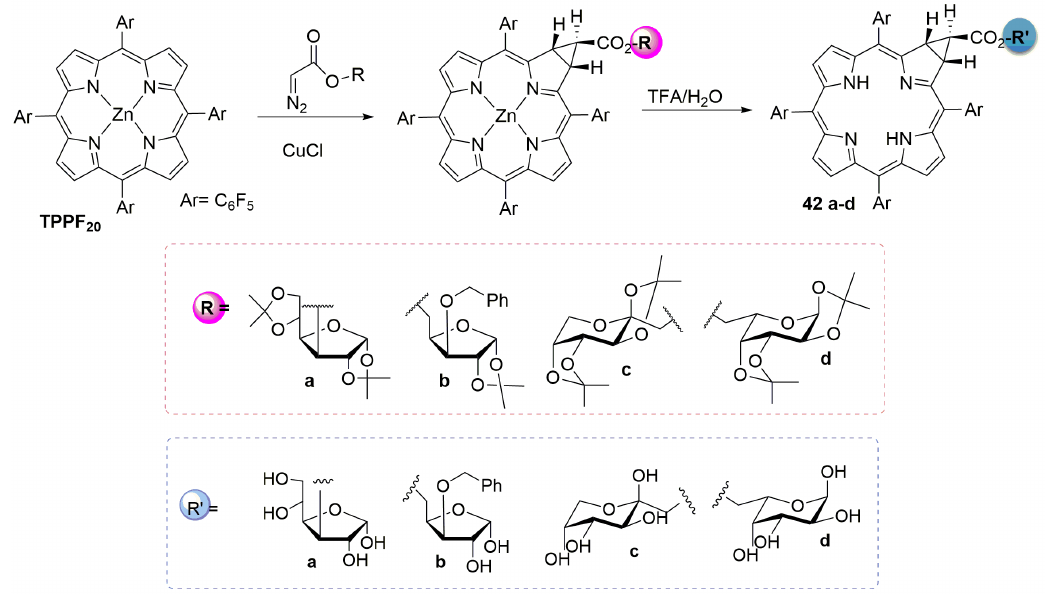
Figure 34 - Synthetic strategy for glycochlorin conjugates 42a-d